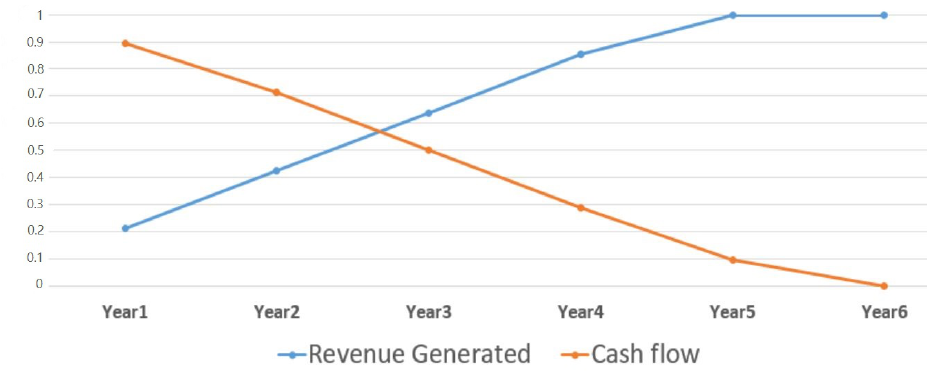
Figure 18. Cash flow graph normalized for a PI-MMS system.